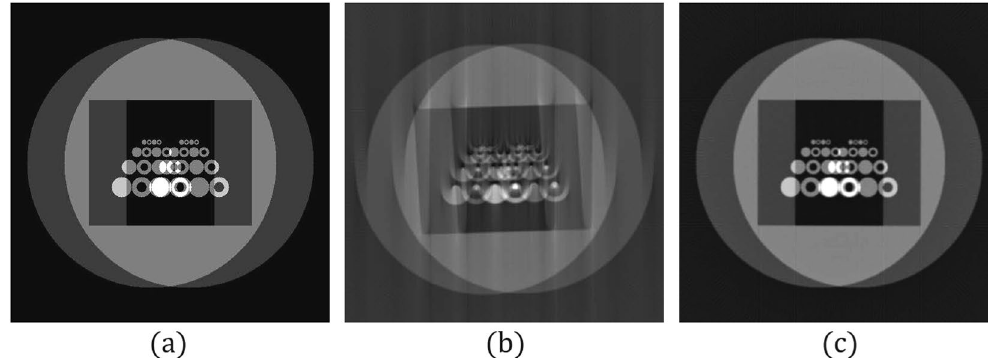
Figure 6. Experiment of the variation of the image of Phantom 2. This image contains more information than the Phantom 2 image. Tomographic images were reconstructed from 180 projections with 512 parallel beams. The interval of angles for generating the projections was 1.02° and the projected rotational axis was shifted to the left by 10 pixels. ( a ) Target image. ( b ) Reconstruction result without error corrections. ( c ) Reconstruction result obtained by the proposed